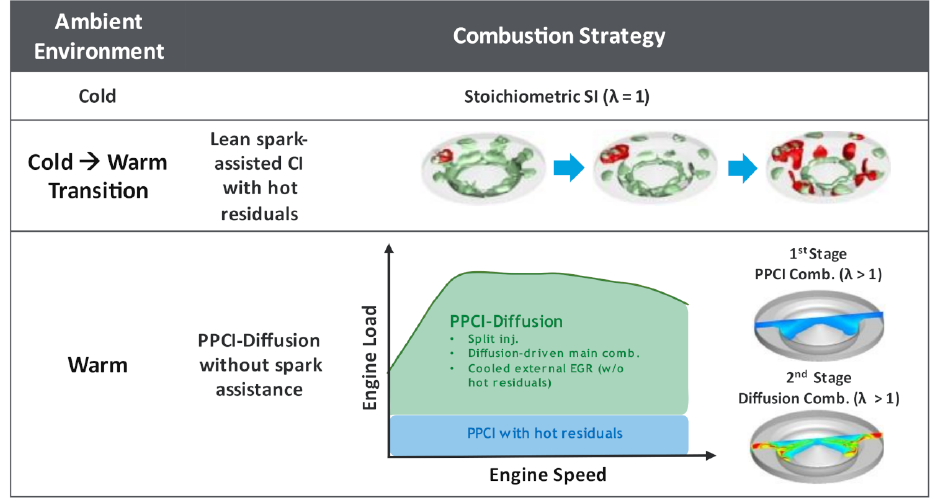
Figure 1. Overview of GCI combustion